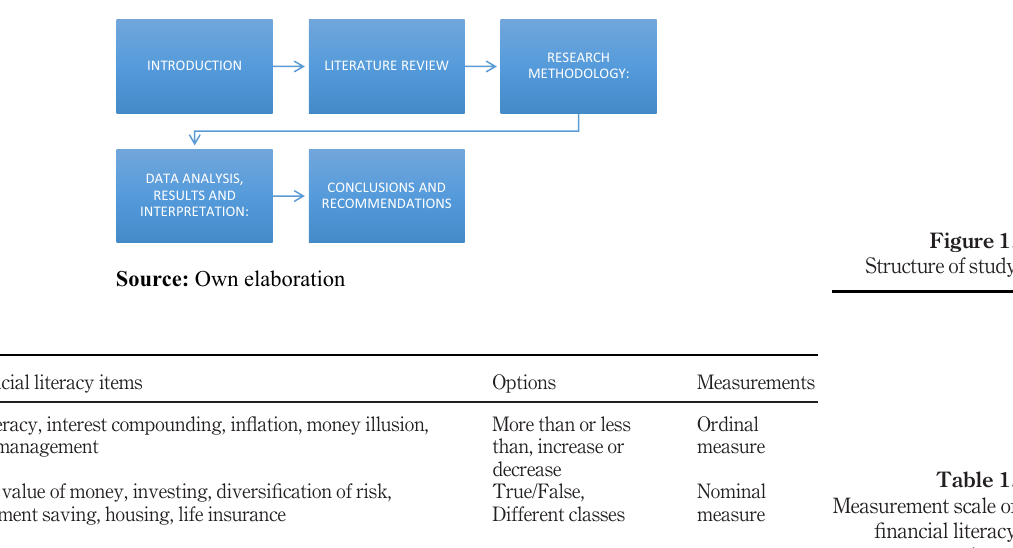
Table 1. Measurement scale